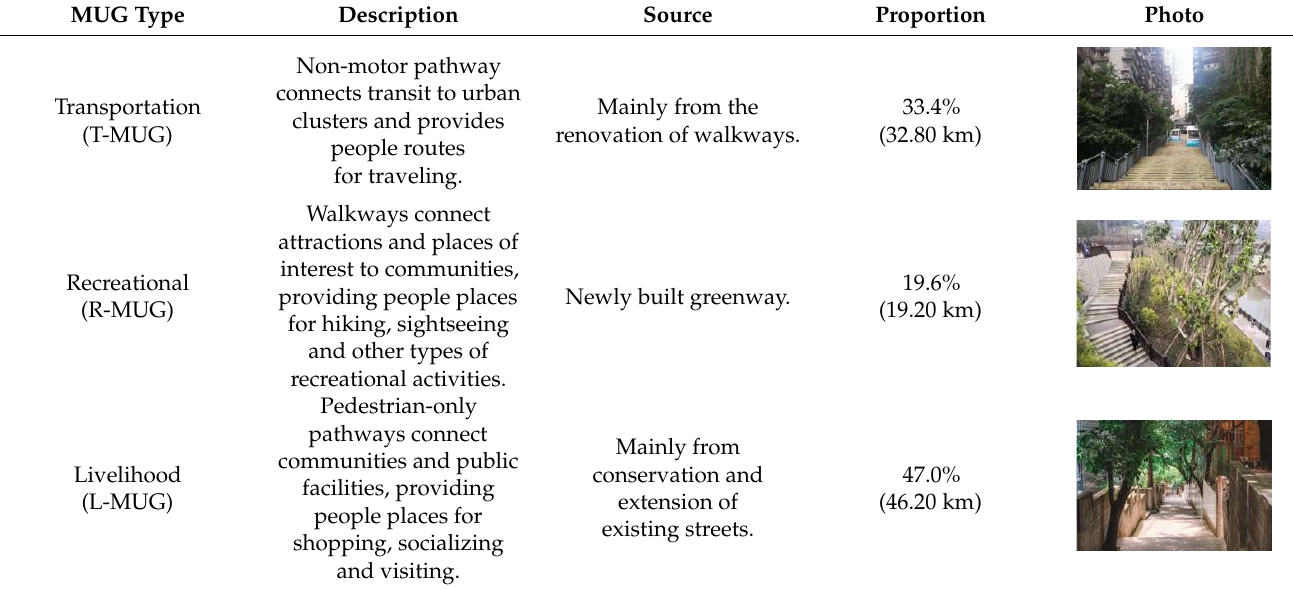
Table 1. Classification of Yuzhong Peninsula MUGs. Original Source: Chongqing City Bureau of Urban Planning.